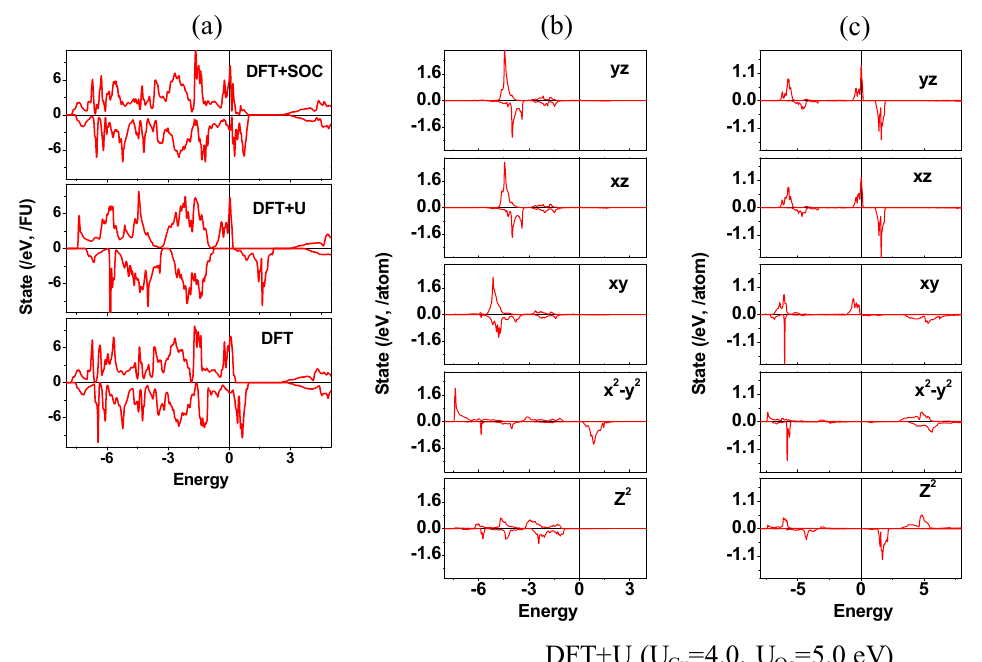
Figure 5. ( a ) Total density of states calculated for FM state of Ba 2 CuOsO 6 obtained from DFT, DFT + U, and DFT + SOC calculations with U Cu = 4 eV, U Os = 5 eV. Projected density of state plots for ( b ) Cu 3d orbitals and ( c ) Os 5d orbitals obtained from DFT + U calculation with U Cu = 4 eV, U Os = 5 eV for the FM state of Ba 2 CuOsO 6 . The spin-up and spin-down states are presented by positive and negative sign in the y-axis, respectively.